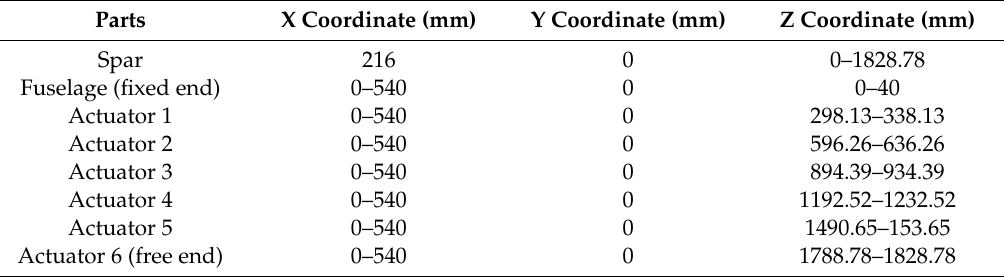
Table 2. Wing boundary conditions and their perspective coordinates.